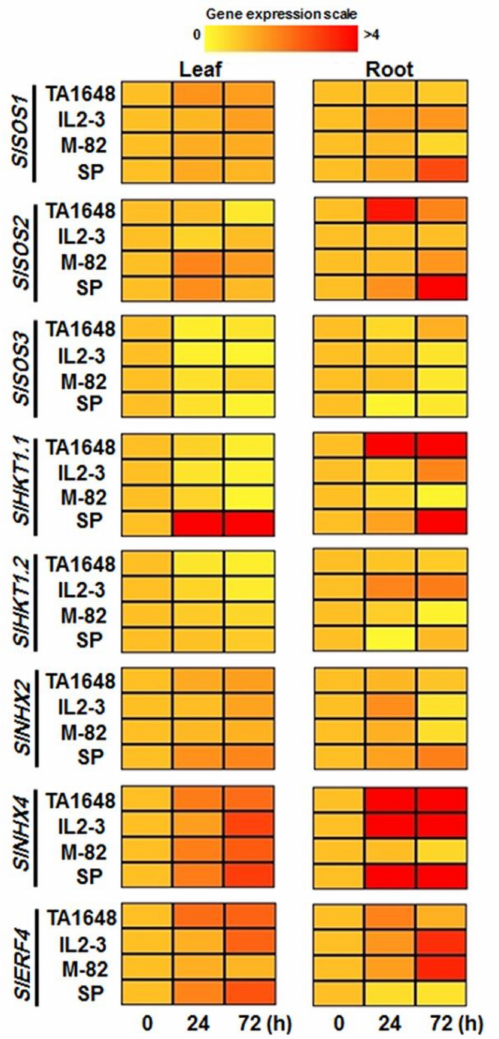
Figure 8. Heat map showing the expression level of eight salt stress-related genes throughout the leaf and root of tomato ILs and their relative parents in response to 120 mM NaCl treatment after 24 and 72 h. Data from qRT-PCR experiments were analyzed according to the 2 − ∆∆ Ct method. The housekeeping actin gene was used as an internal reference control to normalize the expression levels of the target genes. Values are mean ± SD. (n = 3) at p <